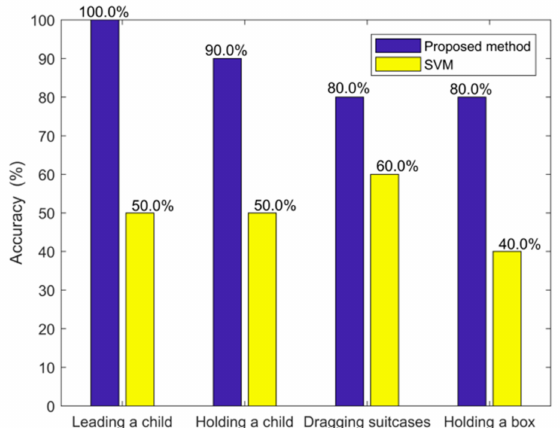
Figure 14. Accuracy in determining the number of persons entering or leaving the room with a child or objects carried.